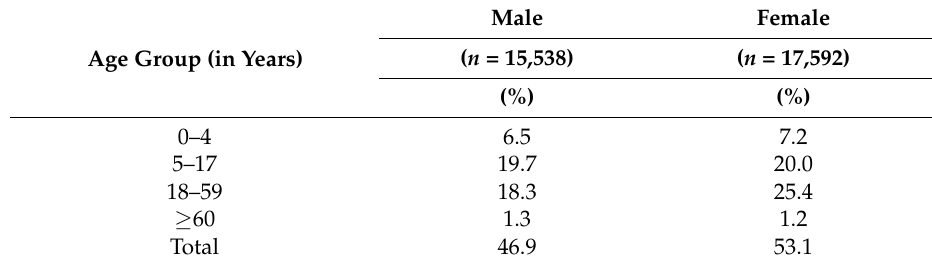
Table 2. Age and sex distribution of Myanmar refugees, RRRC, Bangladesh, 2015 [15].